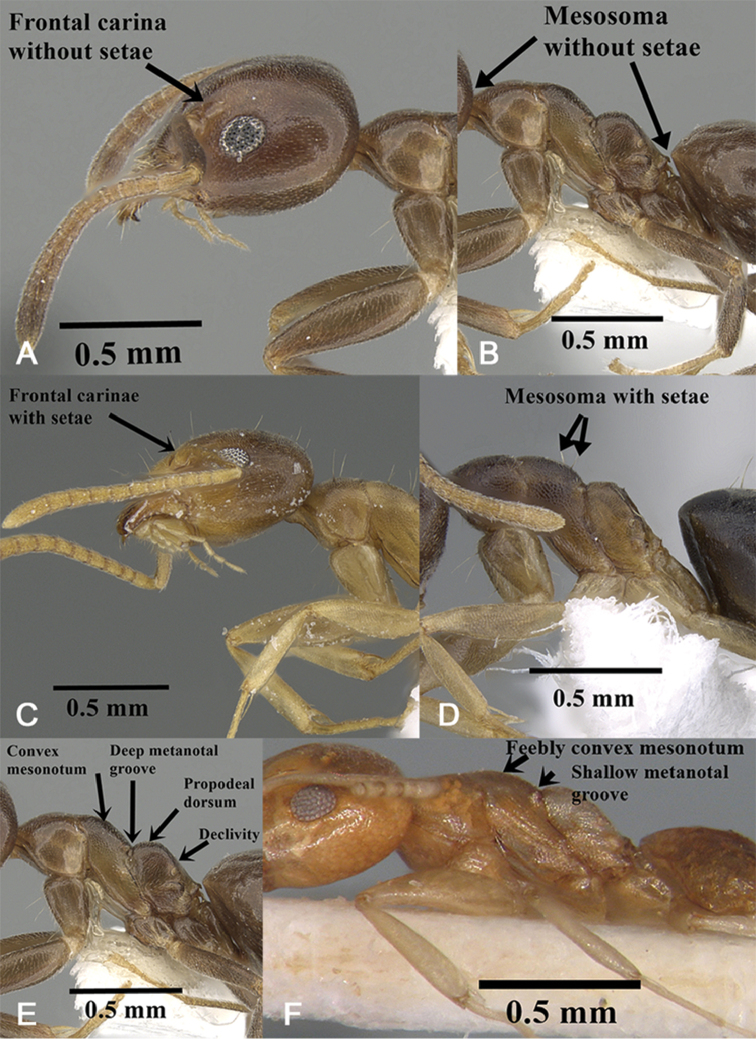
Technomyrmex key illustrations: AT.vexatus, head in profile, CASENT0249804B mesosoma in profile CT.briani, head in profile, CASENT0919799DT.setosus, mesosoma in profile, CASENT0746639ET.vexatus, mesosoma in profile, CASENT0249804FT.montaseri, mesosoma in profile, images from www.AntWeb.org except F.